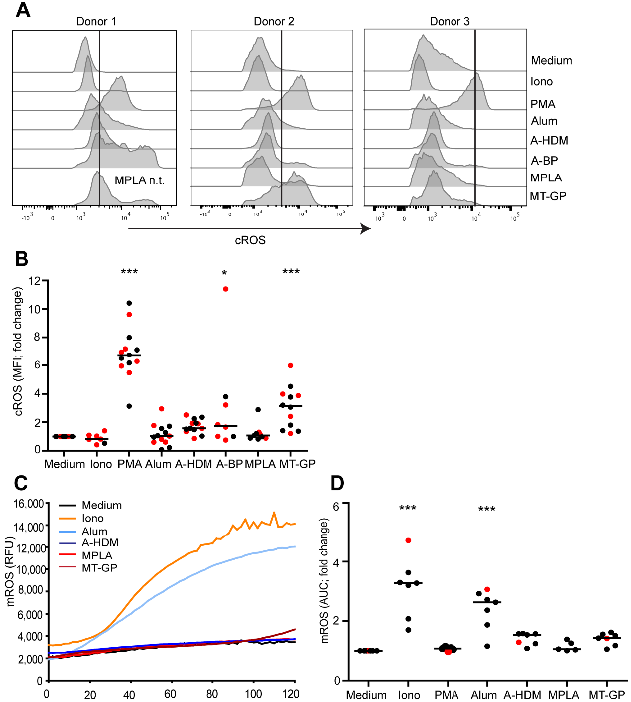
Figure 4. Involvement of ROS in NET release. Neutrophils were incubated with the indicated stimuli in the presence of the mROS indicator MitoSOX red and mROS-induced fluorescence was measured by a plate reader. ( A ) One representative experiment and ( B ) cumulative data of 9 in- dependent experiments with different donors. Areas under the curve (AUC) and fold changes were calculated relative to medium controls. Horizontal lines show medians. ( C , D ) Neutrophils were loaded for 30 min with an indicator for cROS production (CM-H 2 DCFDA) and stimulated for 30 min with medium, ionomycin (Iono; 5 μ M), PMA (25 nM), alum (100 μ g/mL), A-HDM (100 μ g alum/mL), A-BP (100 μ g alum/mL), MPLA (5 μ g/mL) and MT-GP (1 μ g MPLA/mL). cROS pro- duction was assessed by flow cytometry. ( A ) 3 representative experiments from 3 different donors and ( B ) cumulative data of 9 independent experiments with different donors. Red dots indicate allergic donors. n.t., not tested Statistical significance was calculated by one-way ANOVA followed by Dunnett’s post tests (* p < 0.05; *** p < 0.001).